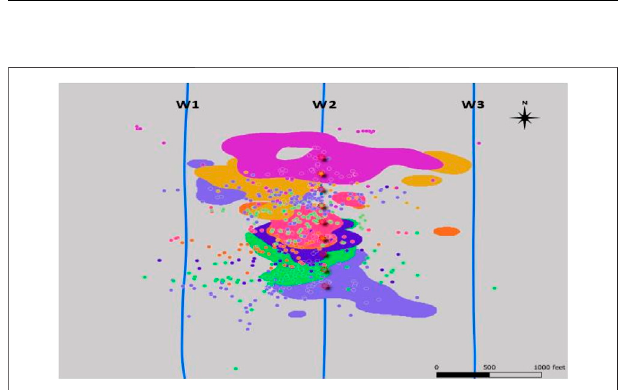
FIGURE 2 | The scattered points in the image are observed micro- seismic events, while the colored laminated areas are observed areas of fracturing fl uid accumulation (Young et al.,